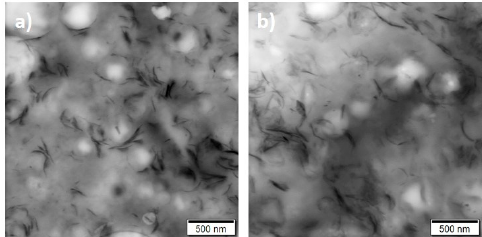
Figure 4. TEM images of extruded films ( a ) before thermal treatment (ME-3.0) and ( b ) after thermal treatment ME-3.0-120.